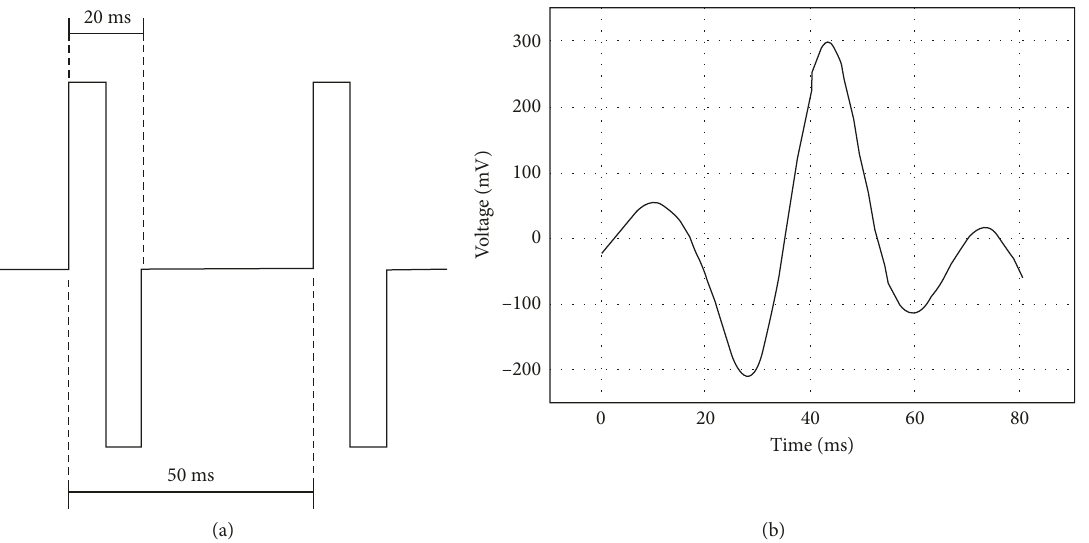
Figure 2: (a) Biphasic waveform applied on the most reported TES; (b) a new voltage waveform approach used in